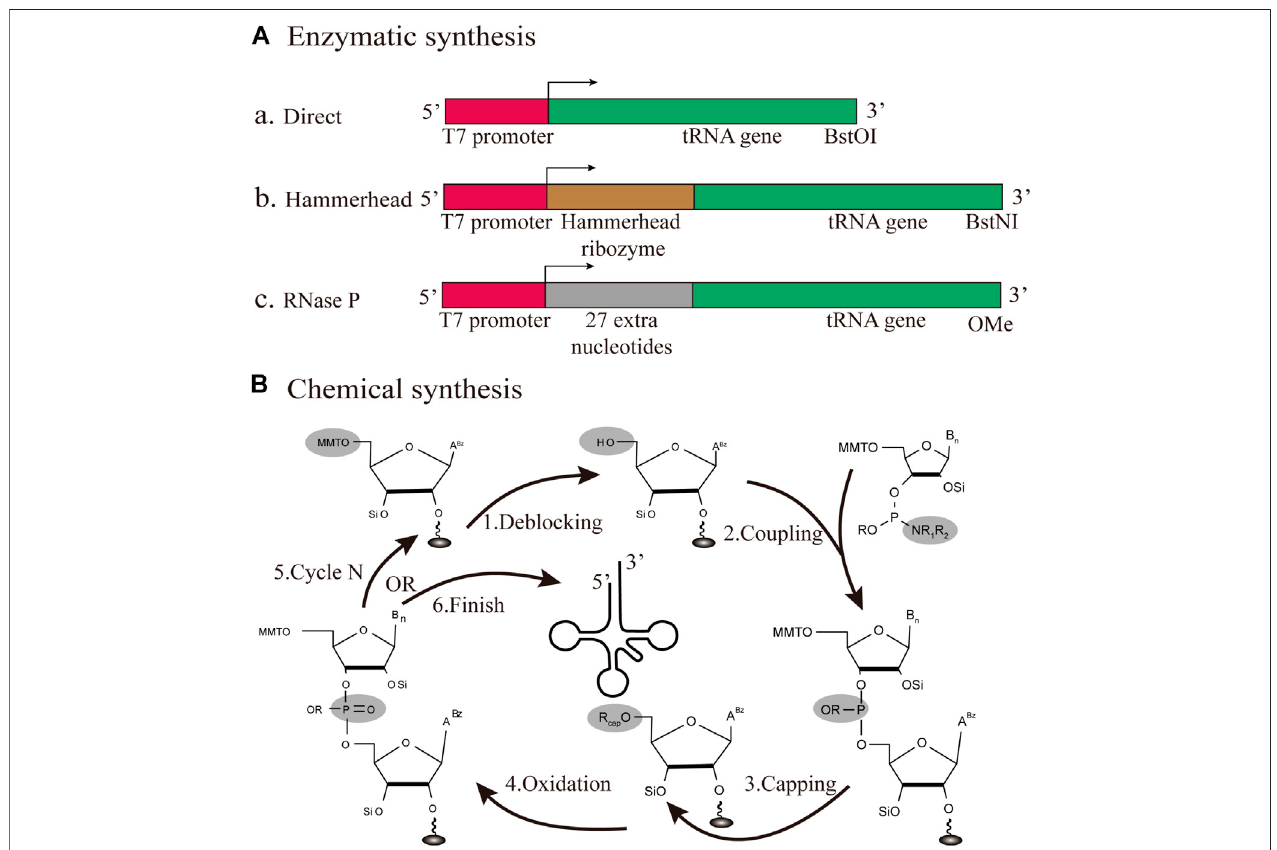
FIGURE 5 | Different strategies for the production of individual tRNAs in vitro (A) Enzymatic synthesis. Three different patterns for tRNA transcription are based on the T7RNP transcription process, including the direct pattern, hammerhead pattern and RNase P pattern (B) Chemical synthesis. The production of tRNA is based on solid-phase chemical synthesis, with each cycle encompassing de-blocking, coupling, capping, and oxidation.